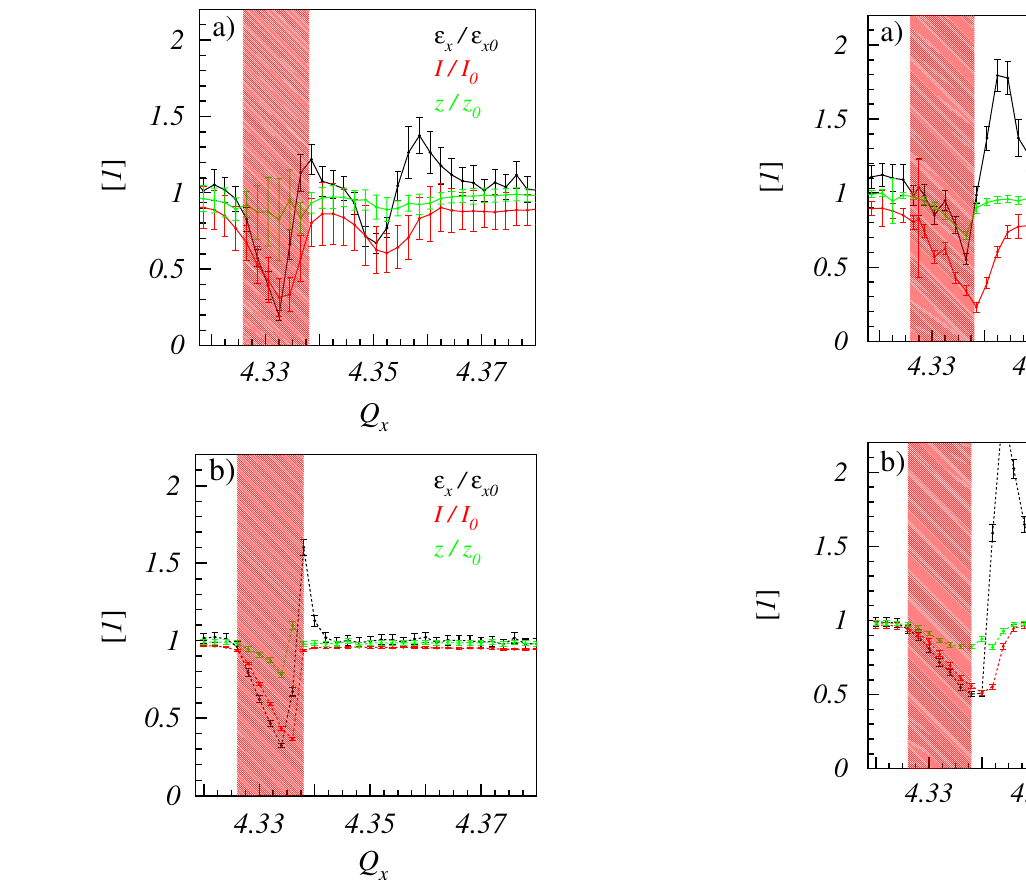
FIG. 14. High intensity bunched beam: (a) Measured transverse-longitudinal beam response to the long-term storage as a function of the working points around the third order resonance. (b) Simulation of the same